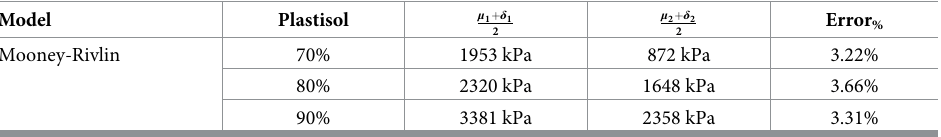
Table 3. Best estimate of material parameters characterising the rheological properties of samples made with dif- ferent plastisol